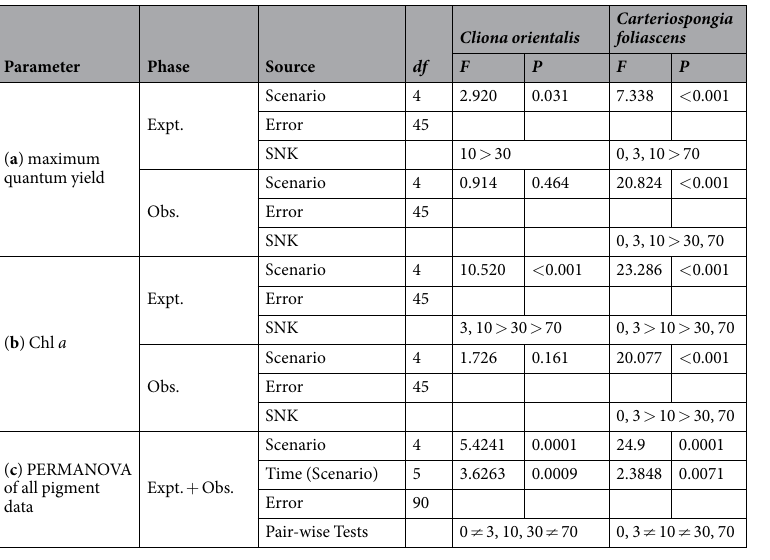
Table 4. Analyses of variance on the effects of turbidity scenarios on photosymbionts. One-way ANOVA examining the effects of turbidity scenarios on ( a ) maximum quantum yield and ( b ) Chl a concentrations, at the end of the experimental and observational periods, with Student Newman-Keuls (SNK) tests performed for significant pairwise multiple comparisons, and ( c ) Two-way PERMANOVA of all pigment data (Chl a , b , c , d , total Chlorophyll and Carotenoids) with scenario and time as factors, for the two phototrophic species (scenarios: 0, 3, 10, 30 and 70